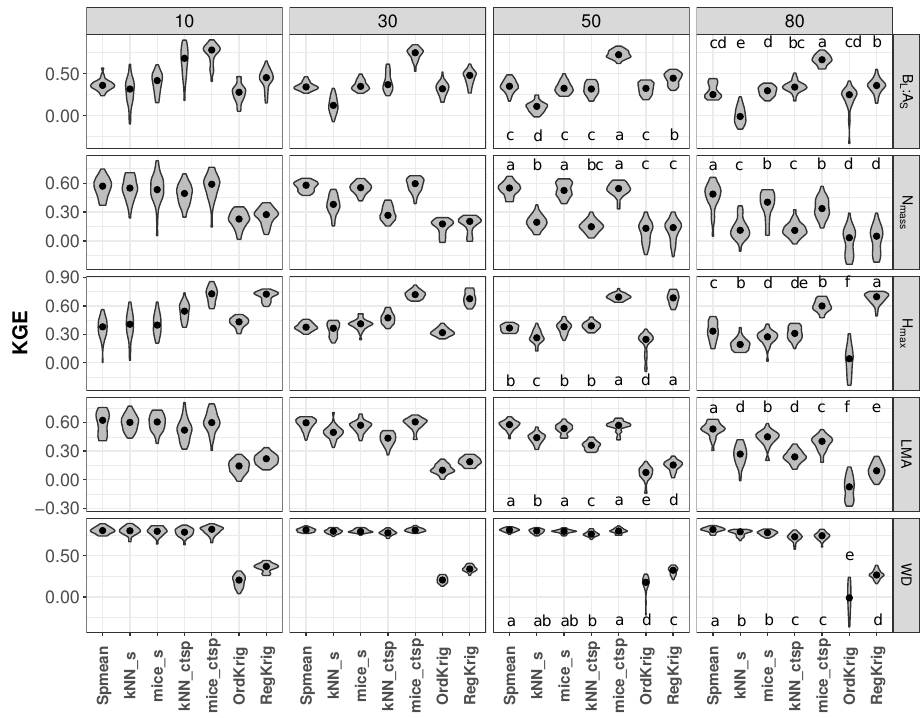
Figure 6. Trait-specific KGE at increasing missingness levels (10–80%) for different imputation methods: species mean (Spmean); mice and kNN with species as predictor (mice_s and kNN_s, respectively); mice and kNN with species, climate, forest structure and spatial variables as predictors (mice_ctsp and kNN_ctsp, respectively); ordinary kriging (OrdKrig); and regression kriging (RegKrig). Higher values of KGE imply higher performance. Traits: leaf biomass to sapwood area ratio, B L : A S (tm − 2 ); leaf nitrogen per unit mass, N mass (%mass); maximum tree height, H max (m); leaf mass per area, LMA (mgcm − 2 ); wood density, WD (gmcm − 3 ). Higher values of KGE imply higher performance. Letters denote results of multiple comparisons, in alphabetical order from highest to lowest